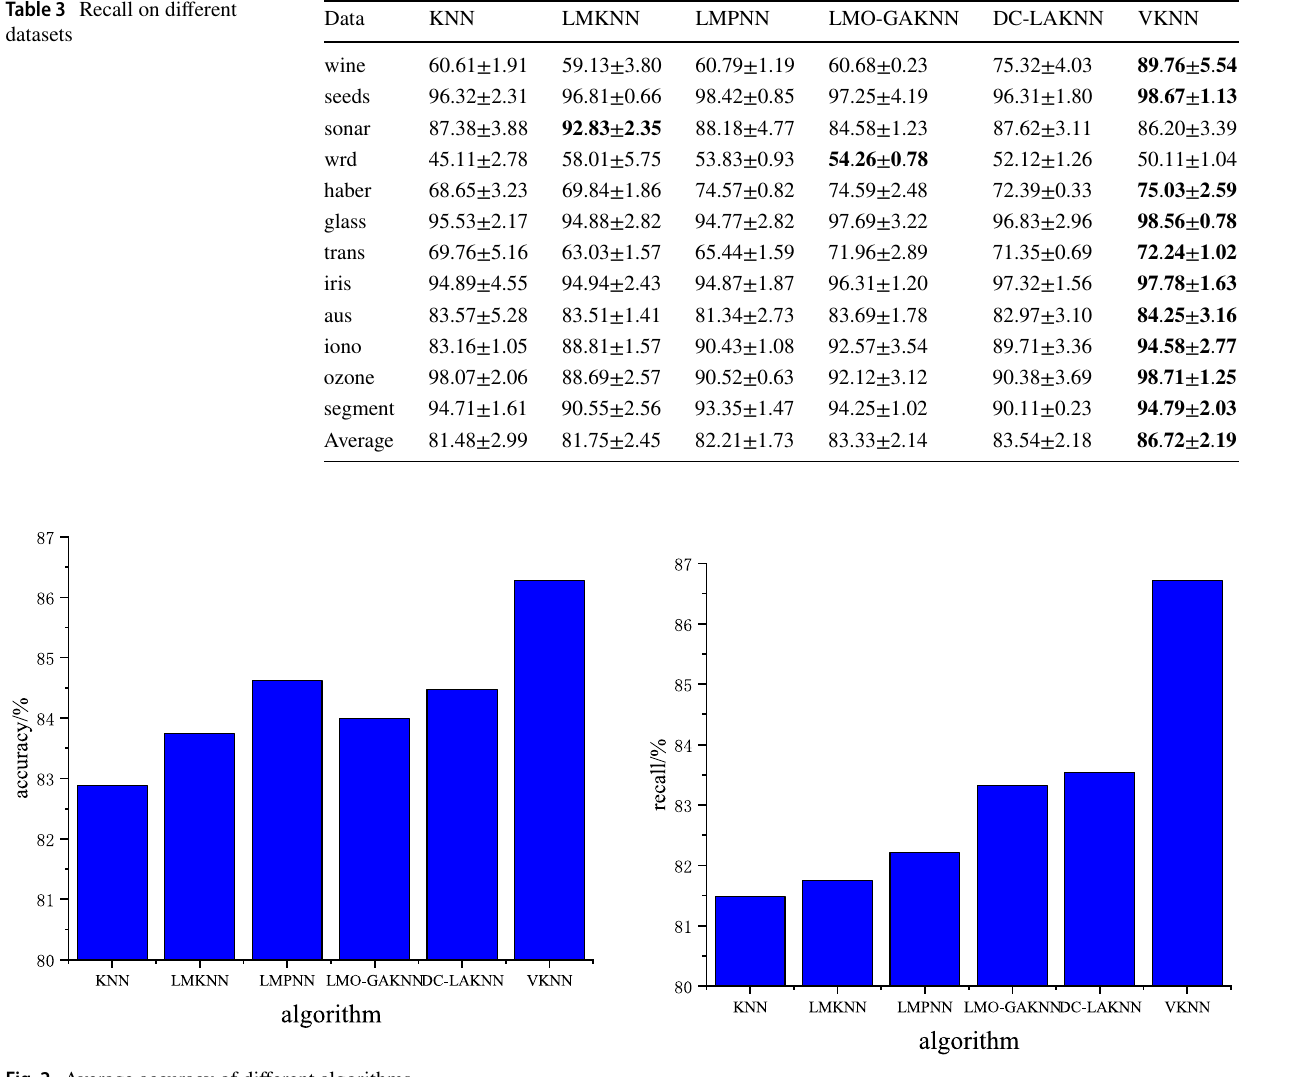
Fig. 3 Average recall of different